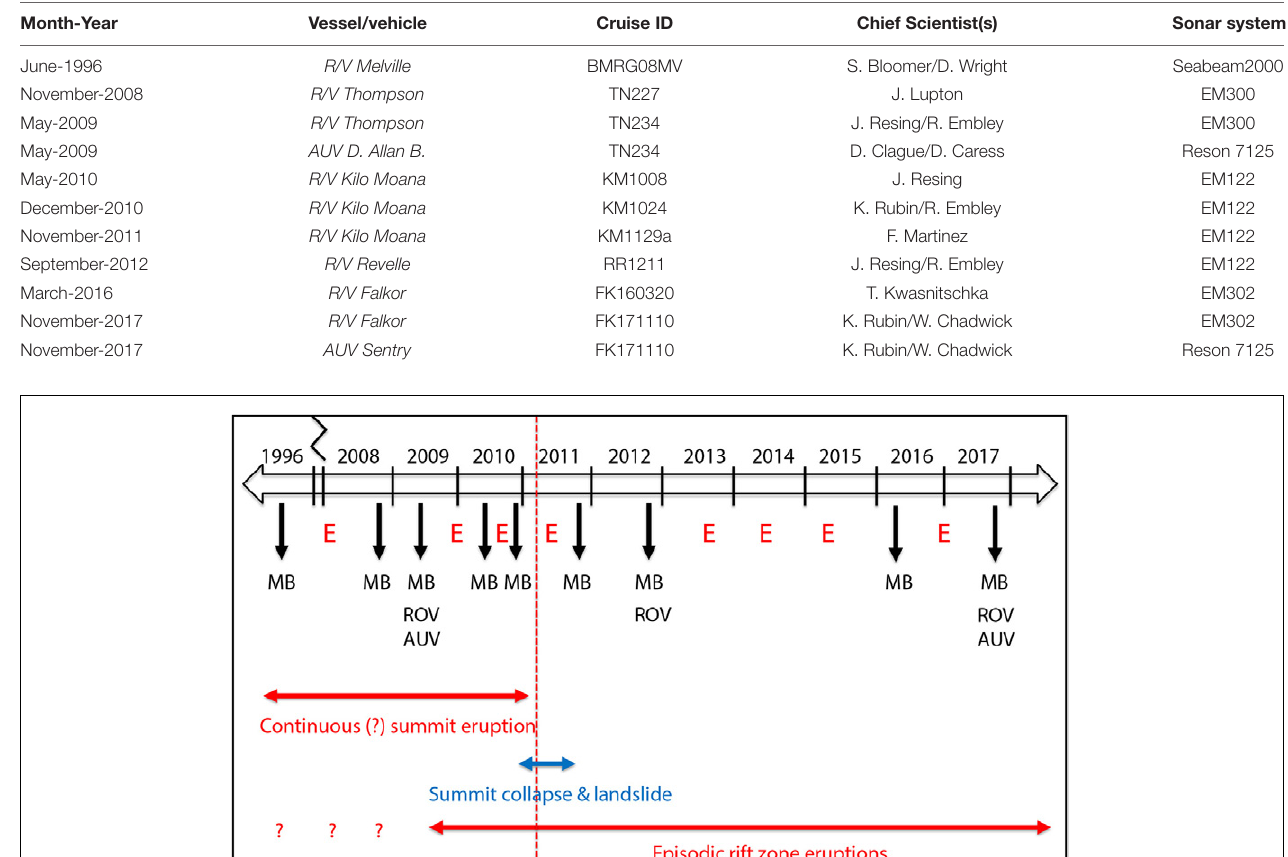
TABLE 1 | Multibeam sonar bathymetric surveys at West Mata volcano.